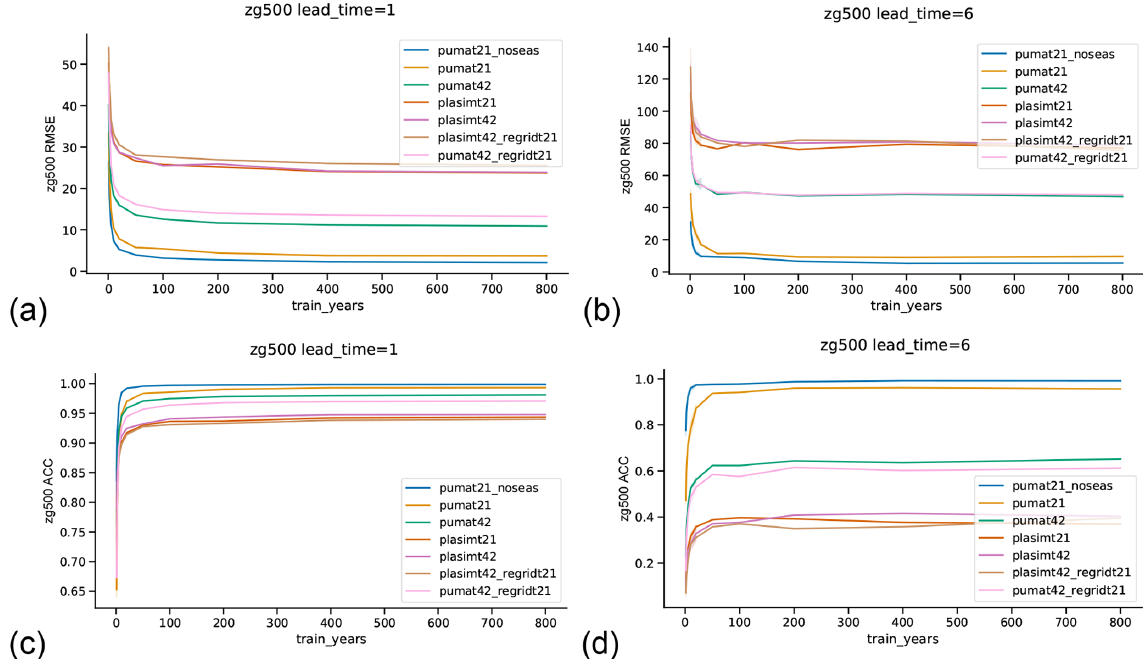
Figure 5. Dependence of network forecast skill on the length of the training period. Shown is the root mean square error (RMSE) and anomaly correlation coefficient (ACC) of the network-forecasted 500hPa geopotential height for networks trained on different amounts of training years. Each line represents one model. The shading on the left side of the plots represents the 5–95 uncertainty range of the mean RMSE or ACC, estimated over networks with different training